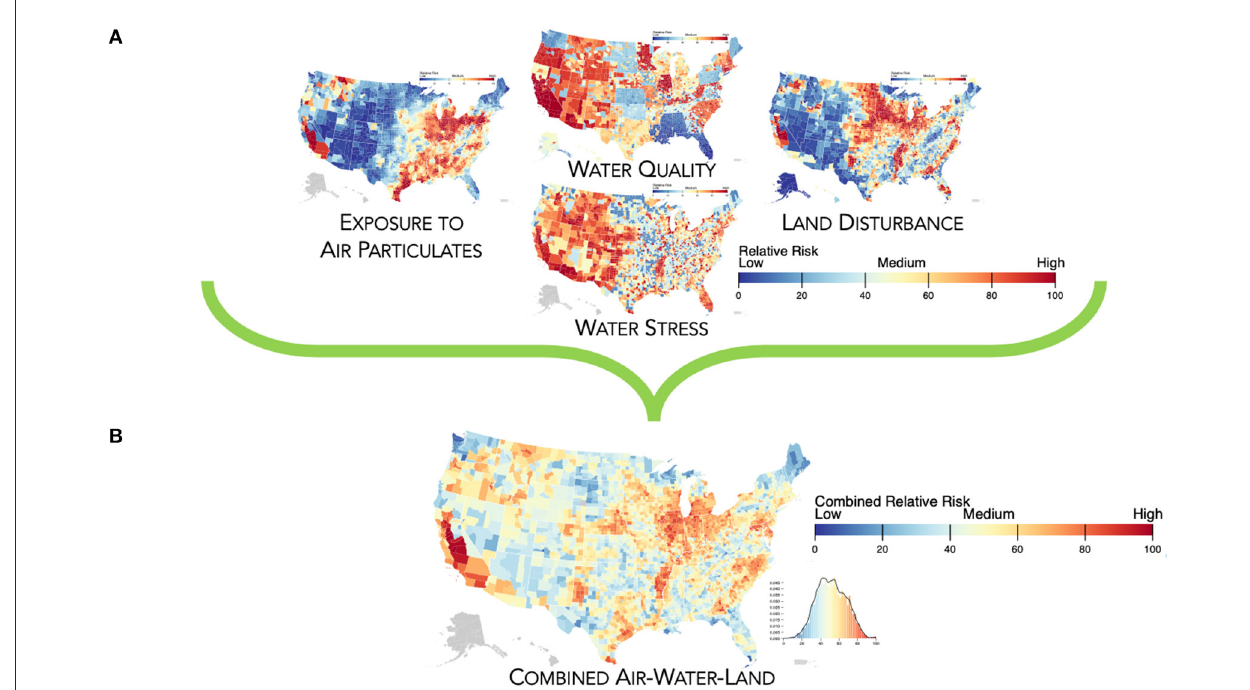
FIGURE3 Shown is an example of the combinatory metric analysis provided by the risk-triage framework. In the top panel (A) , the maps show the results for each metric of exposure to air particulates, water stress, water quality, and land disturbance. In the bottom panel (B) , the result of the four metrics, combined with equal weighting, is shown. In all panels, the risk metric is unitless and is the result of the normalization procedure (described in Section 2.2). Shades of orange and red indicate the counties with the highest relative risk, while shades of blue indicate the lowest relative degree of